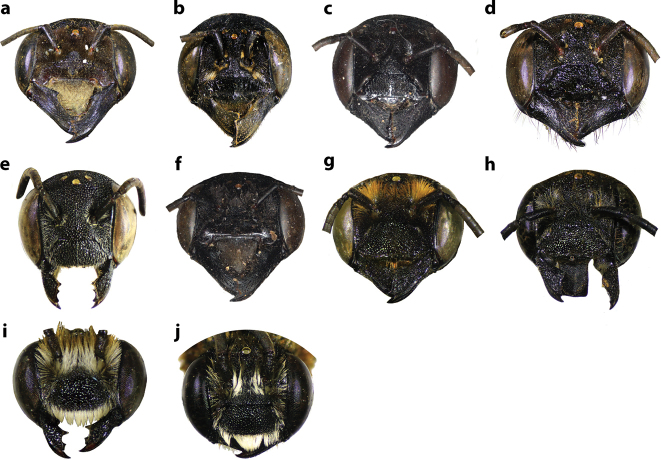
Frontal view of some Thai Callomegachile (a–h females, i, j males) aM. (Callomegachile) monticolabM. (Callomegachile) odontophoracM. (Callomegachile) ornatadM. (Callomegachile) parornataeM. (Carinula) stultafM. (Callomegachile) tuberculatag, iM. (Callomegachile) umbripennishM. (Callomegachile) umbripennis (BSRU AA-4620) jM. (Callomegachile) umbripennis (BSRU AA-3654, BSRU AA-3662 and KKIC-02).